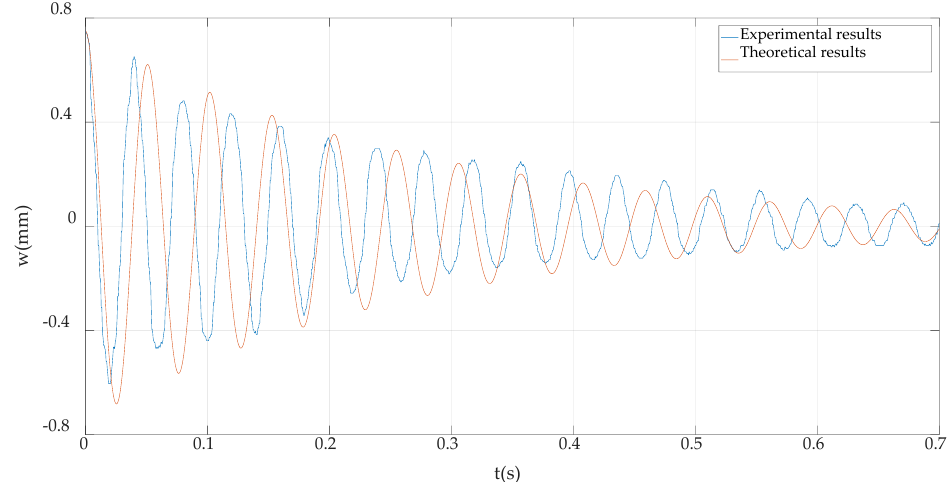
Figure 5. The time–displacement curves under the initial displacement of 0.750 mm.